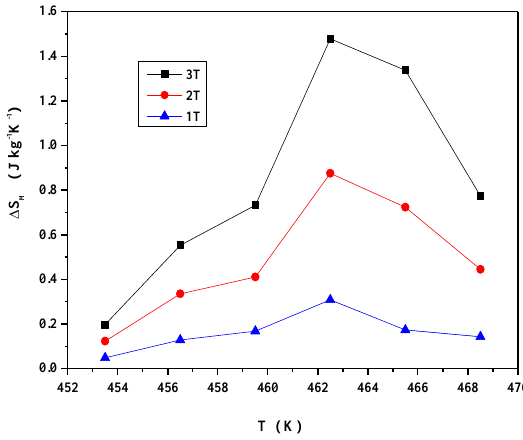
Figure 22. Magnetization isotherms for the Co 1 − x Ni x In 2 (x = 0.540) alloy.